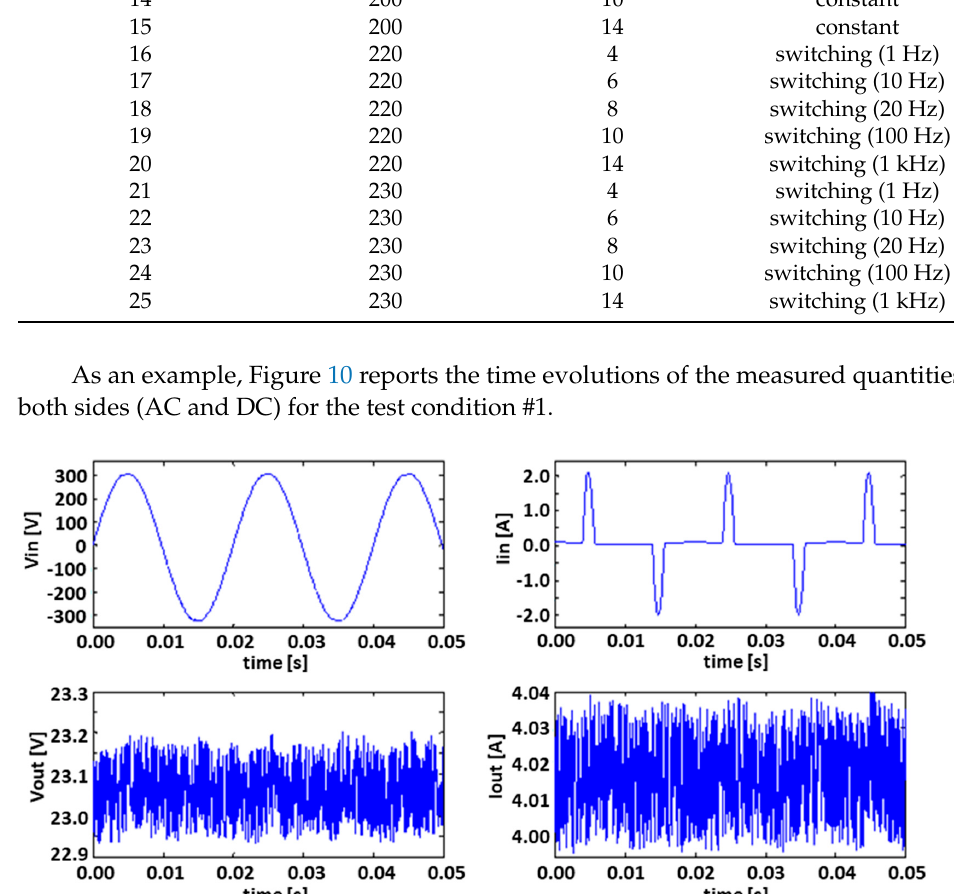
Table 3. Overall experimental values of the quantities of influence.